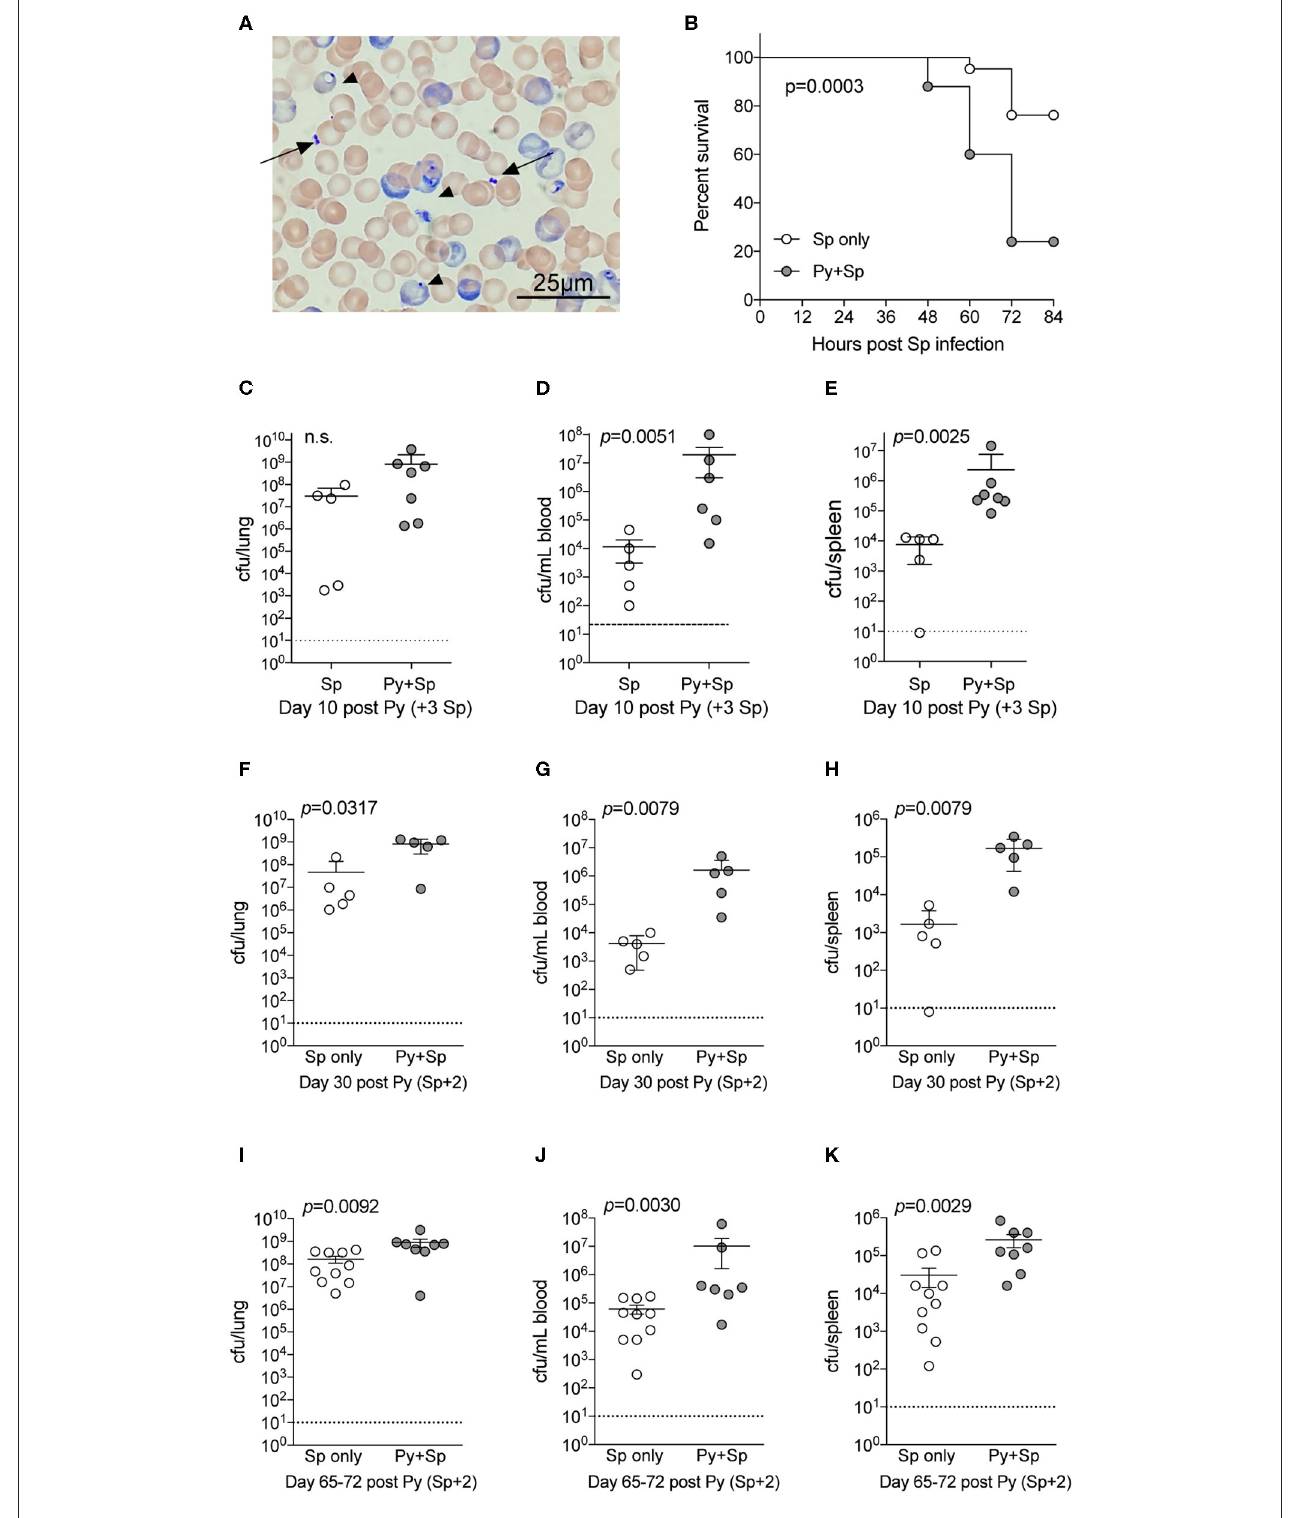
FIGURE 2 | P. yoelii infection increases severity of Pneumococcal infection. C57BL/6N mice were infected (i.v.) with 10 5 P. yoelii infected RBCs, 7-days later Py-infected and naïve mice were infected (i.n.) with 10 6 CFU Streptococcus pneumoniae (Sp). (A) Giemsa stained blood smear from co-infected mouse. Arrows